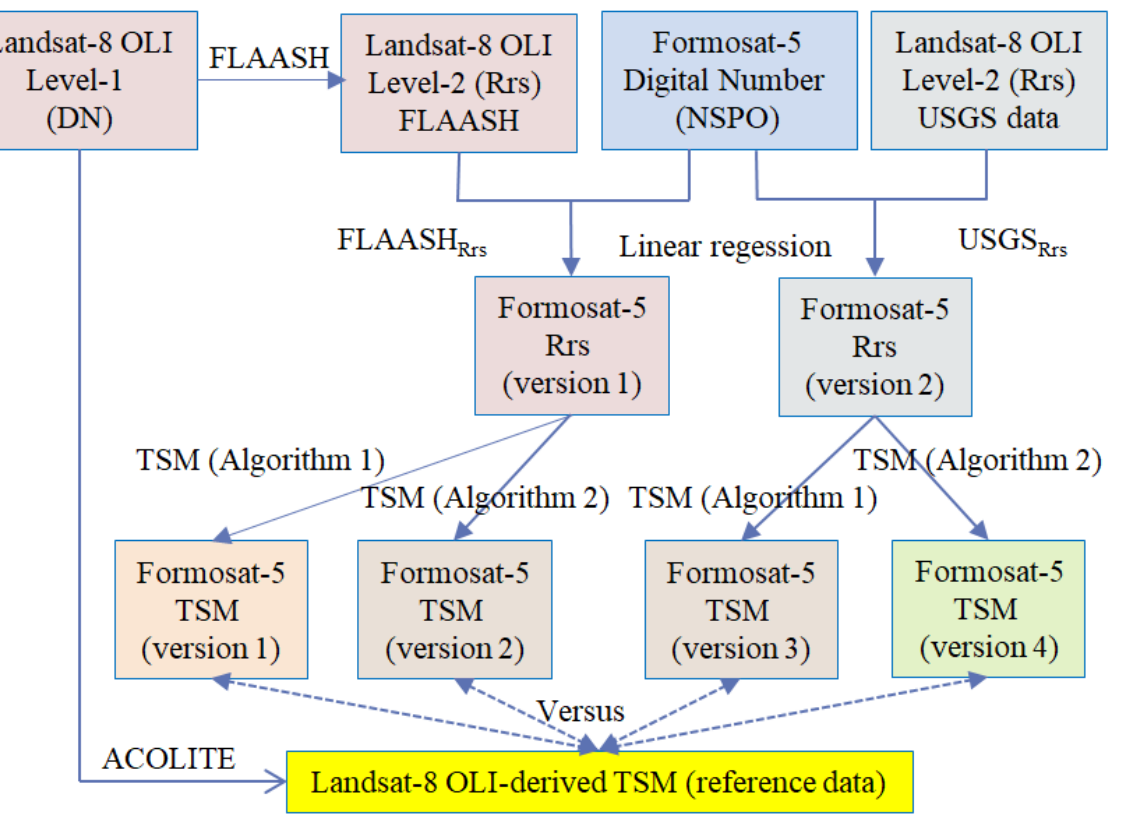
Figure 3. Flowchart of data processing.